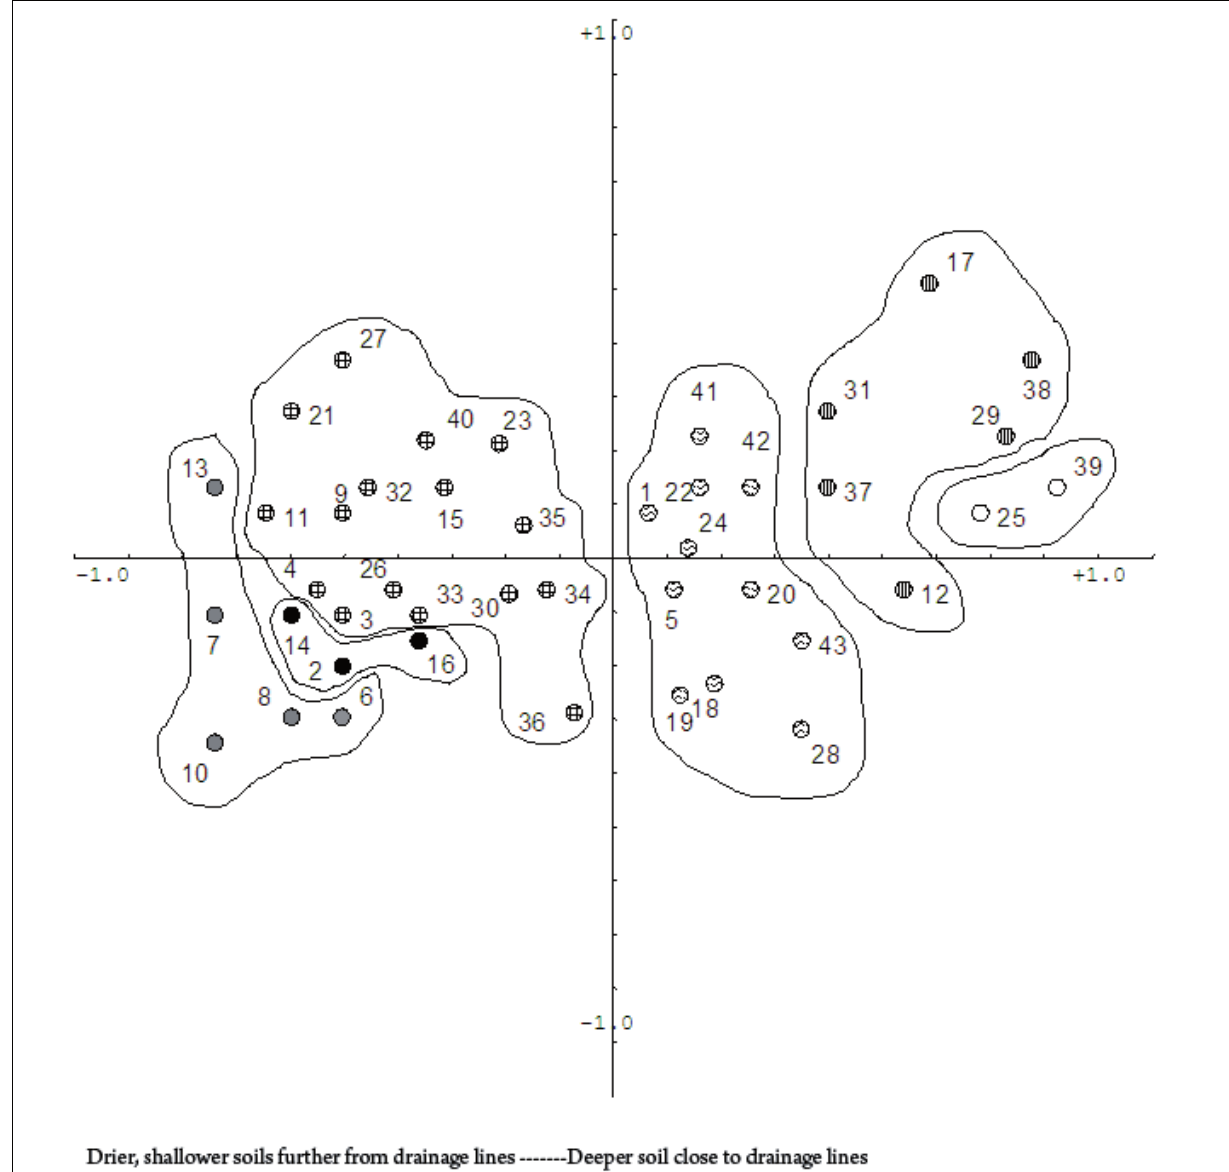
Figure 4 Standardised PCA of all plots depicting a gradient from areas with deep soils near drainage lines and riparian areas to higher-lying areas further away with shallower soils